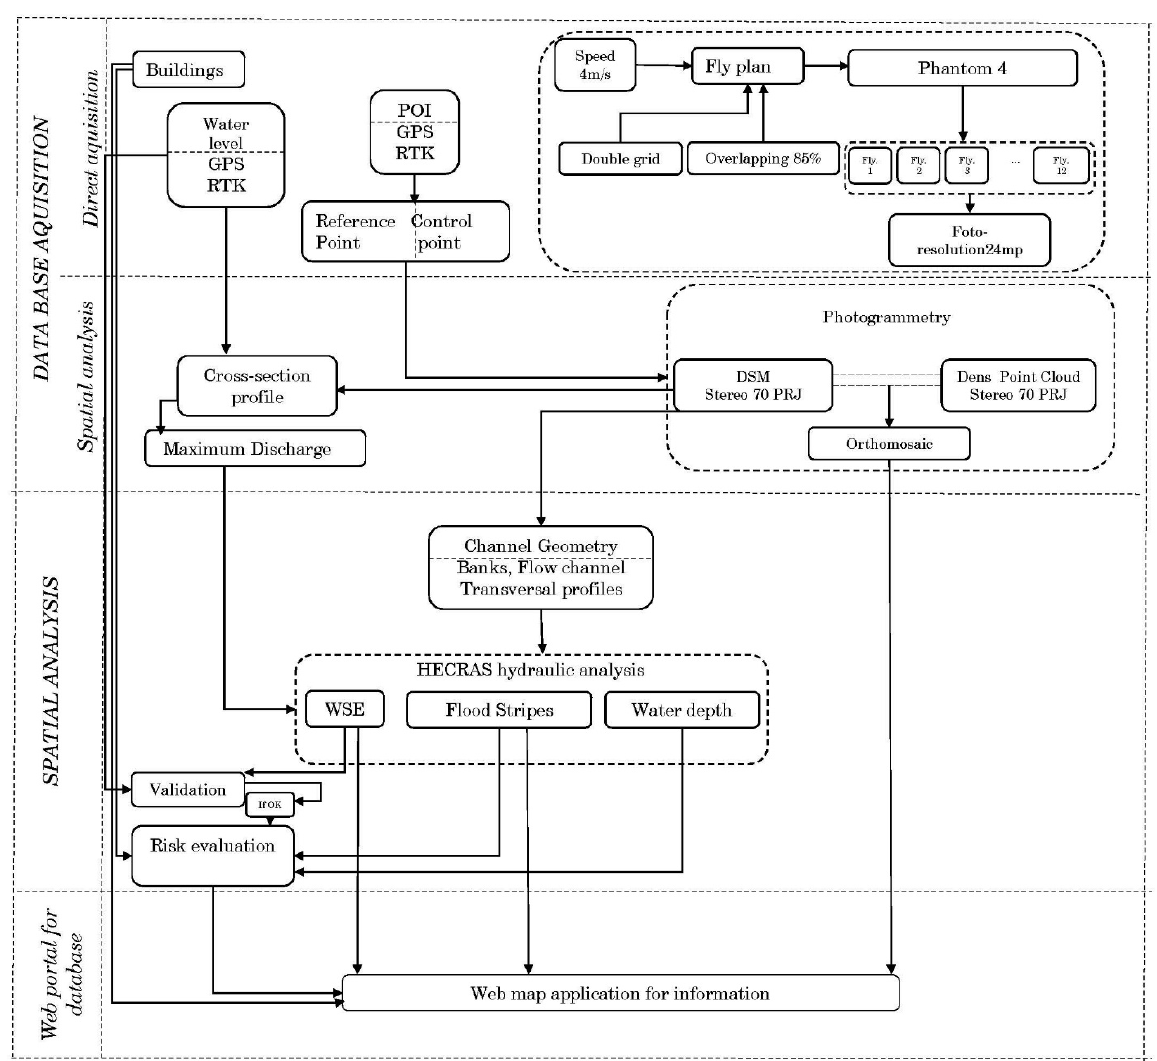
Figure 2. Methodological flowchart.